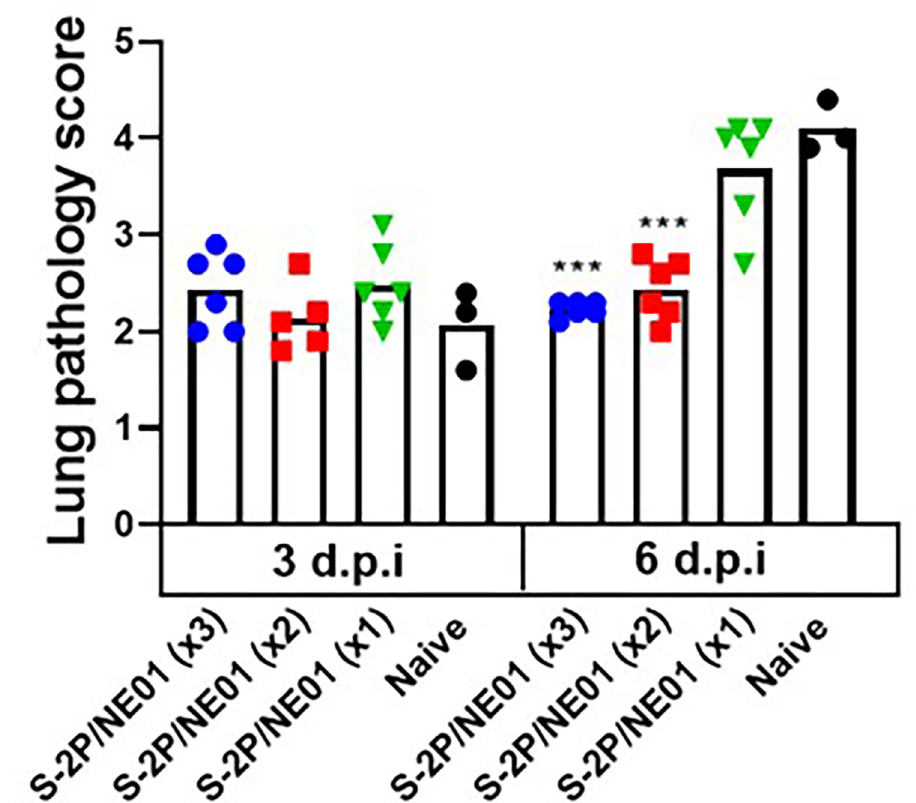
Fig 6. Intranasal S-2P/NE01 protects hamsters from lung pathology following infection with SARS-CoV-2. Hamsters were euthanized 3- and 6-days post challenge and lungs were collected for histopathological analysis. The lung sections were scored, and mean results are presented with error bars representing standard error. Statistical analysis calculated using one-way ANOVA with Tukey’s multiple comparison test.